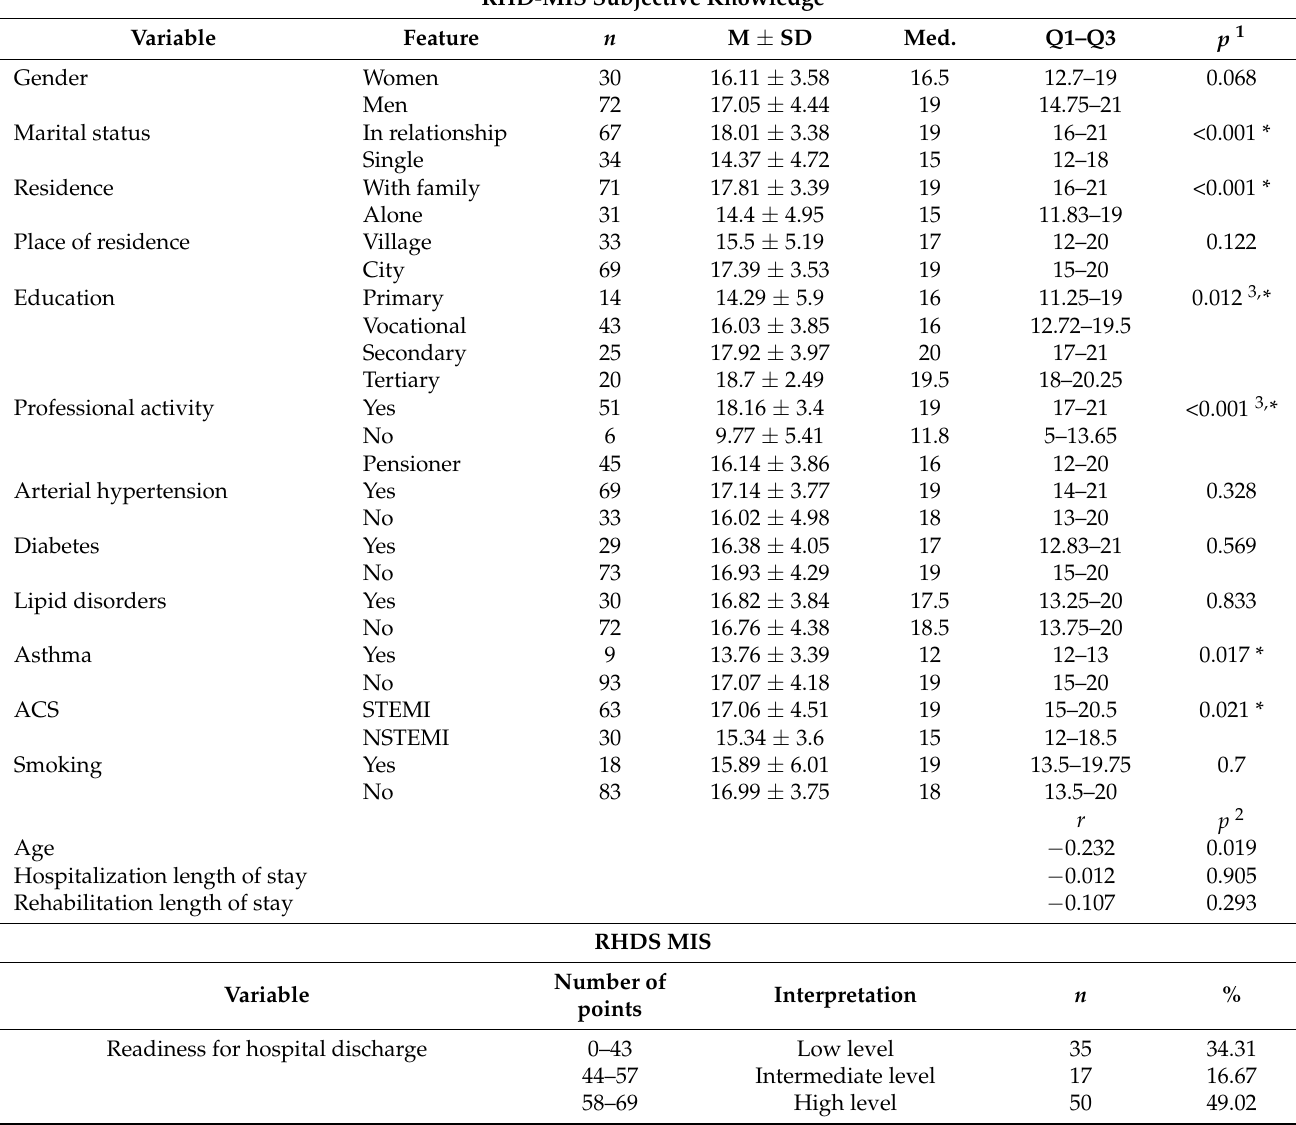
Table 3. Effects of socio-demographic and clinical variables on subjective knowledge about the disease in MI patients. RHD-MIS Subjective